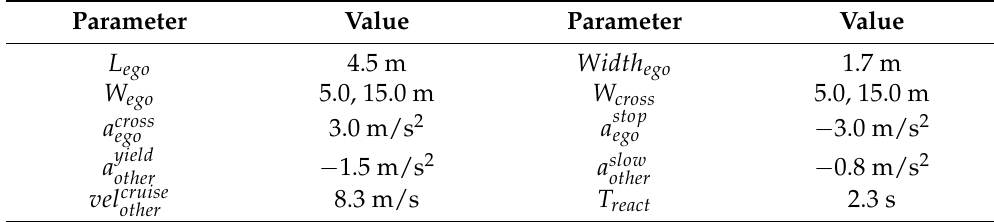
Table 1. Values of major parameters used in the